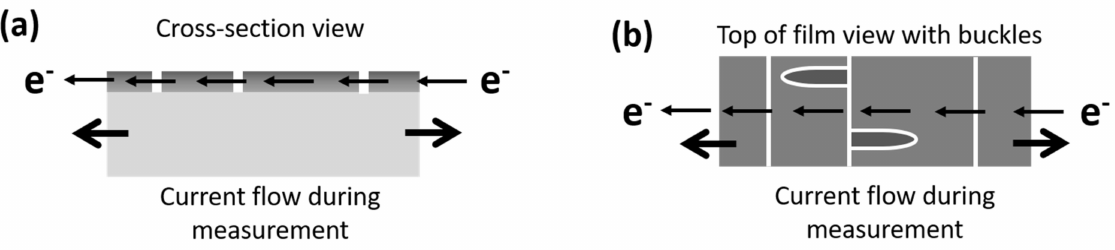
Figure 6. ( a ) Electrical resistance measurements are performed perpendicular to the TTCs. ( b ) If the film forms buckles, the measured resistance will not be influenced because buckles are parallel to the measurement direction. Resistance cannot be used to detect